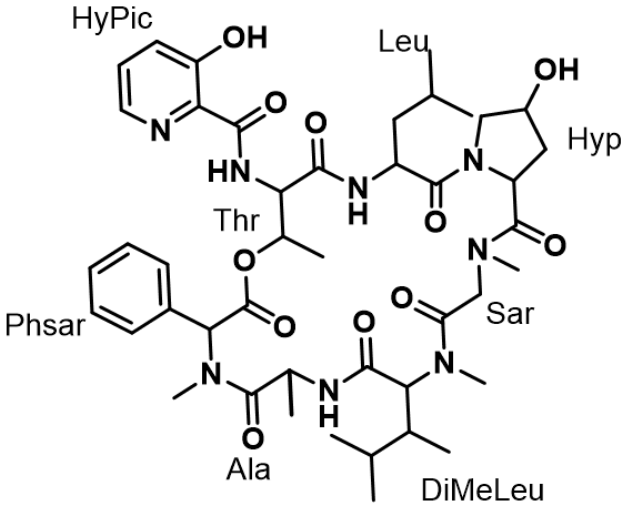
Figure 1. The planar structure of PHAR110904 ( etamycin).